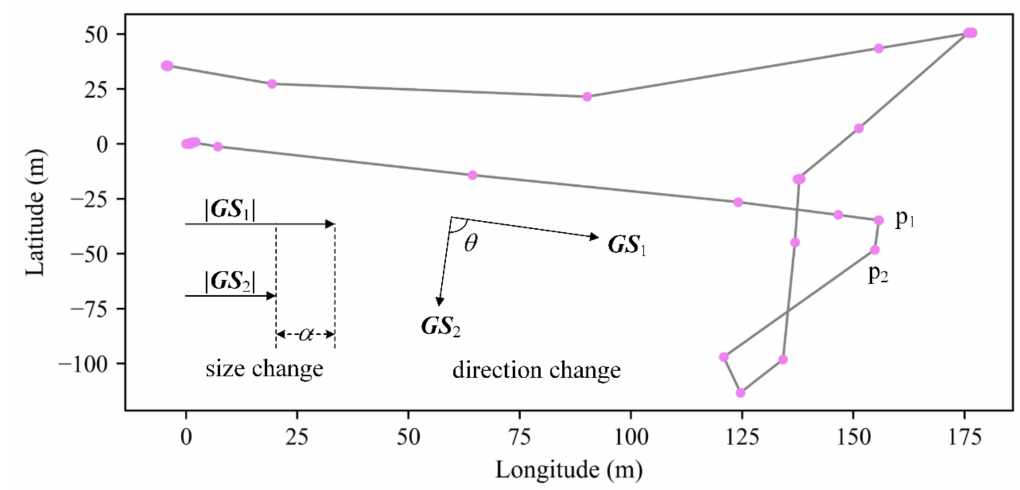
Figure 3. The change in ground speed ( GS ) from the top view.